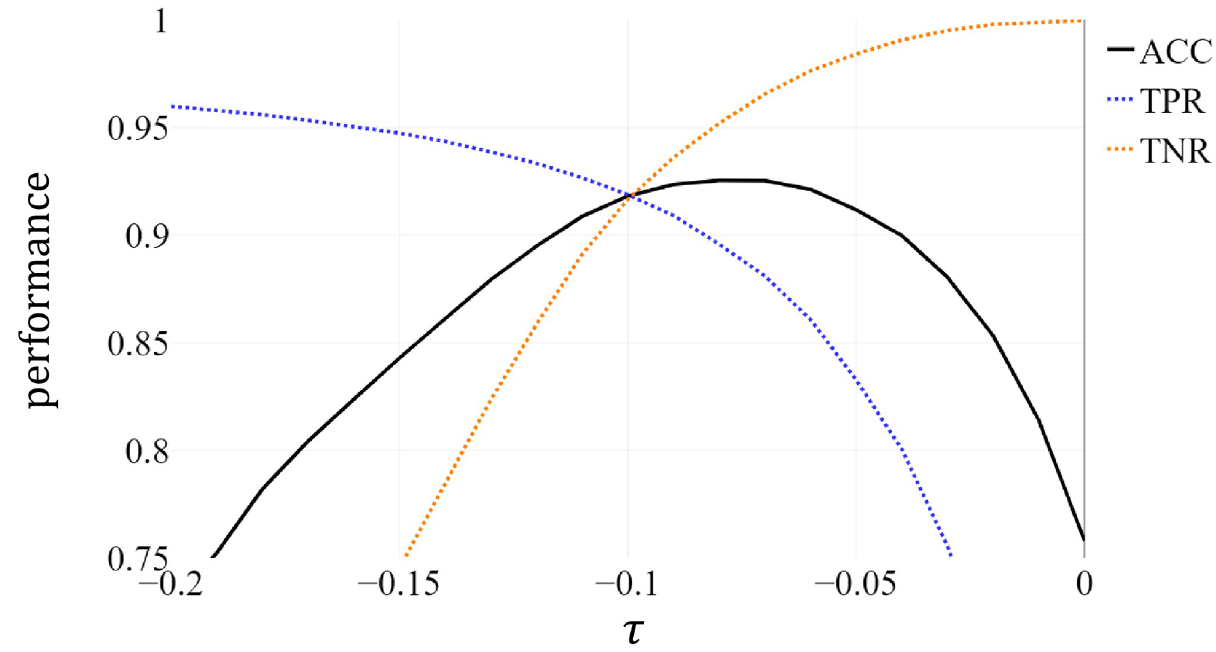
Fig 9. Performance as a function of τ for fixed values of γ = 2.2, ν = 0.06, and λ = 1.0.